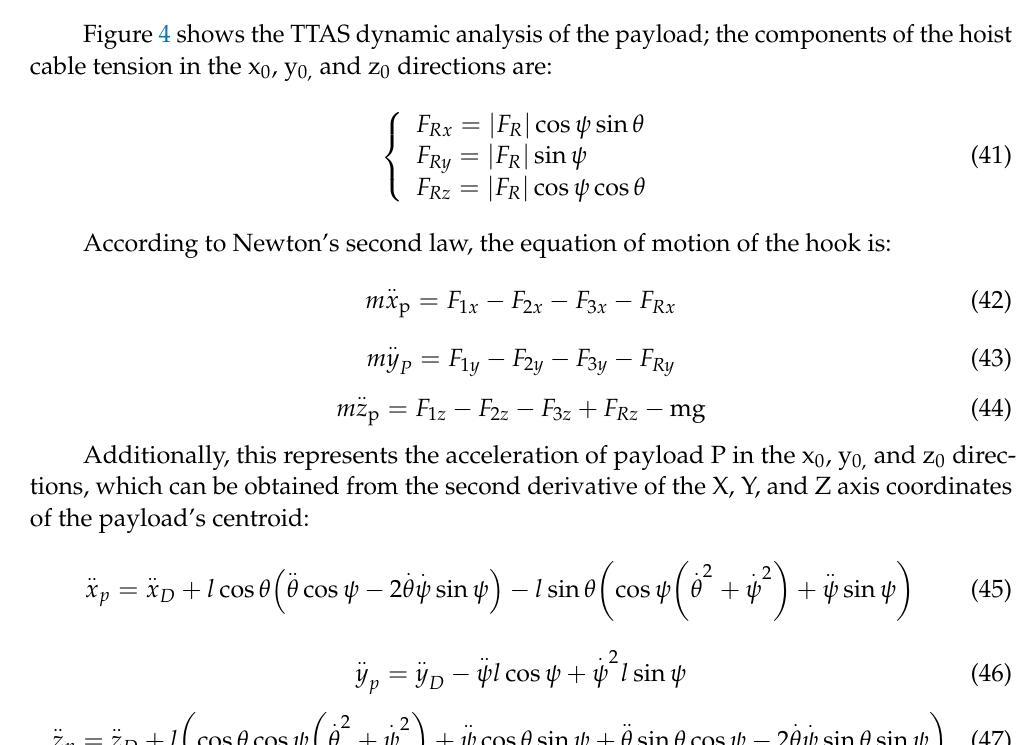
Figure 6. Schematic diagram of the dynamic model: ( a ) schematic diagram of the three-dimensional dynamic model; ( b ) stress analysis diagram of the two-dimensional dynamic model.